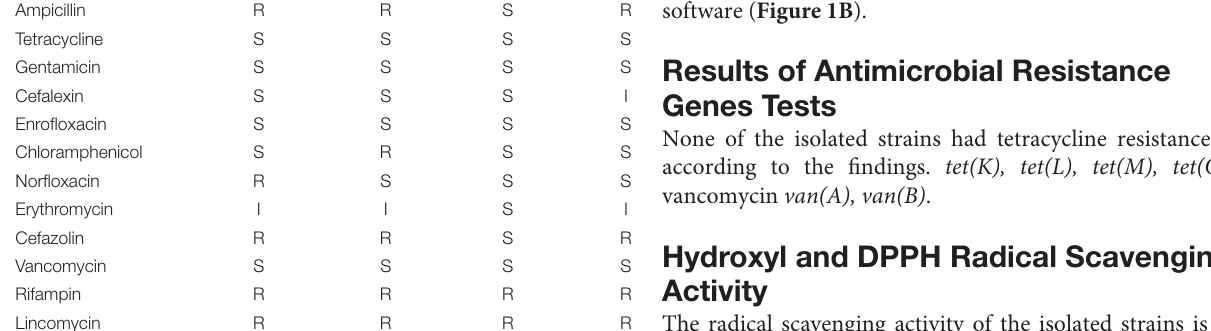
( Table 2 ). The phylogenic tree was constructed based on the 16S rRNA gene, using the neighbor-joining method with MEGA 7 software ( Figure 1B